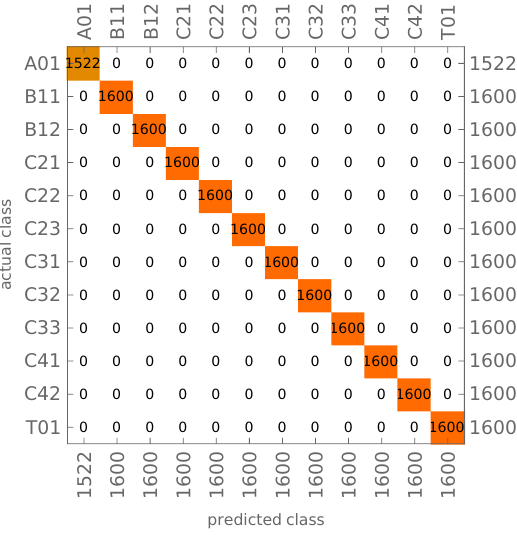
Figure 6. The results of CNN- O mode shapes identification for different